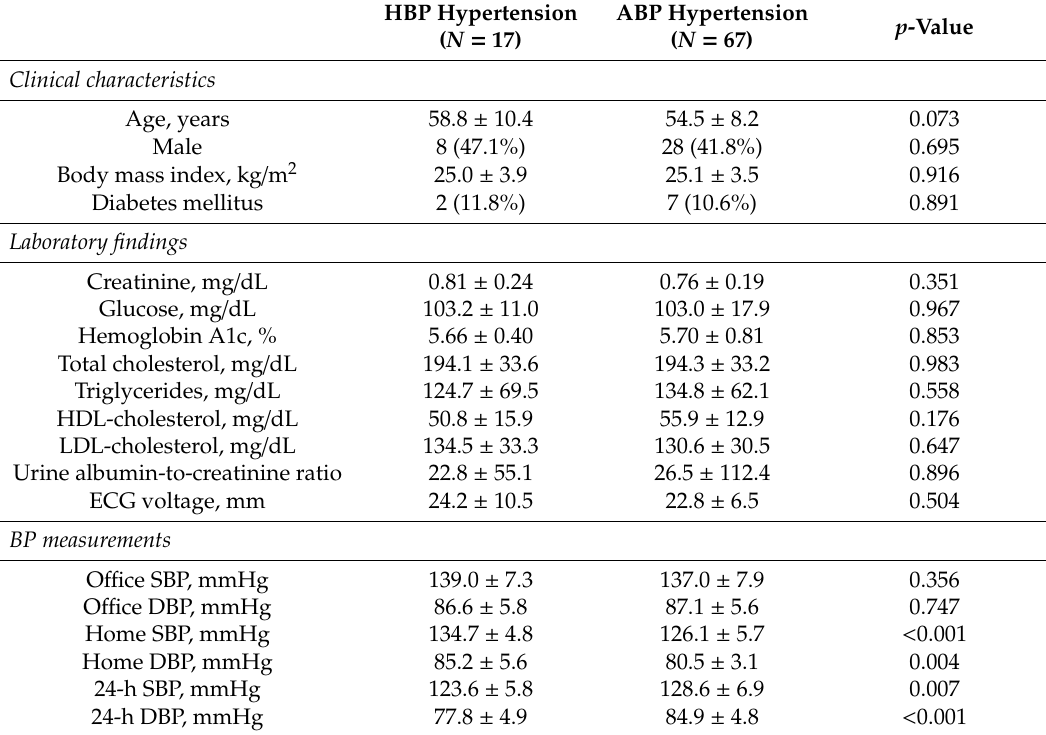
Table 7. Demographic and clinical characteristics of the individuals in the Disagree